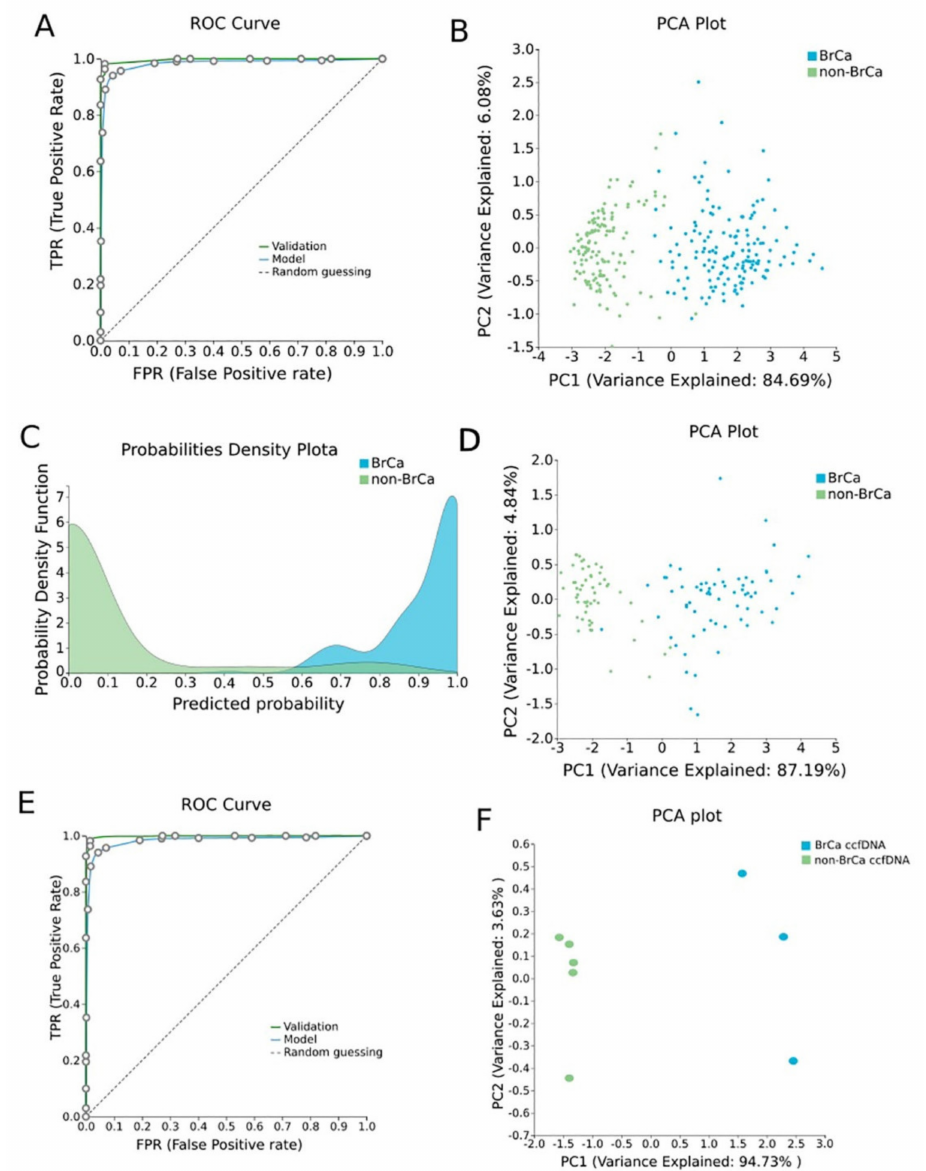
Figure 2. BrCa-specific methylation biosignature built using AutoML. ( A ) ROC curves of training (blue line) and validation (green line) models. ( B ) Supervised PCA plot (i.e., only considering the selected relevant biomarkers) presents separation between BrCa (blue) and healthy tissues (green) within the training group. ( C ) Out-of-sample probability density plot (i.e., probability predictions when samples were not used for training) depicts discrete distributions among studied classes of the training group. ( D ) PCA plot presents separation between BrCa (blue) and healthy tissues (green) within the validation group. ( E ) ROC curves of training (blue line) and external validation (green line) models and ( F ) PCA plot presents separation between BrCa ccfDNA (blue) and healthy ccfDNA (green) within the external validation group. Abbreviations: BrCa = breast cancer, ROC = receiver operating characteristic, PCA = principal component